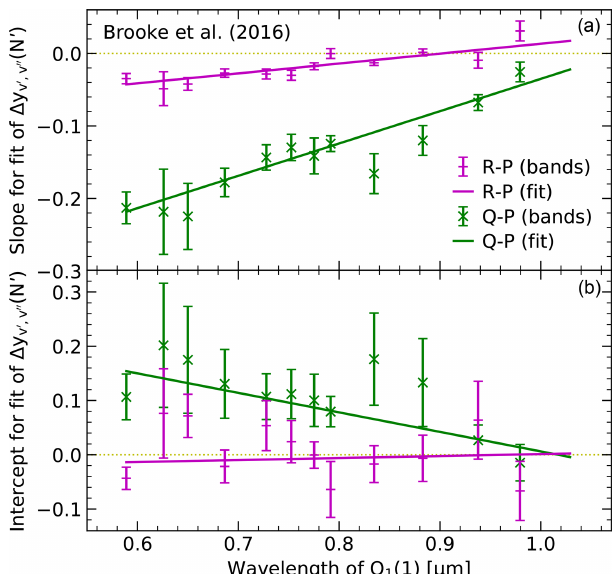
Figure 10. Fit of the differences in logarithmic OH level popula- tions for Q (crosses) and R branches (horizontal bars) relative to the P branch as a function of the upper rotational level N (cid:48) for each band where a reliable linear regression could be performed. The symbols with error bars show the resulting slope (a) and intercept (b) and their respective uncertainties. These values based on Einstein- A co- efficients of Brooke et al. (2016) were also fitted by performing error-weighted linear fits depending on the wavelength of Q 1 (1) for each band. The fit lines are